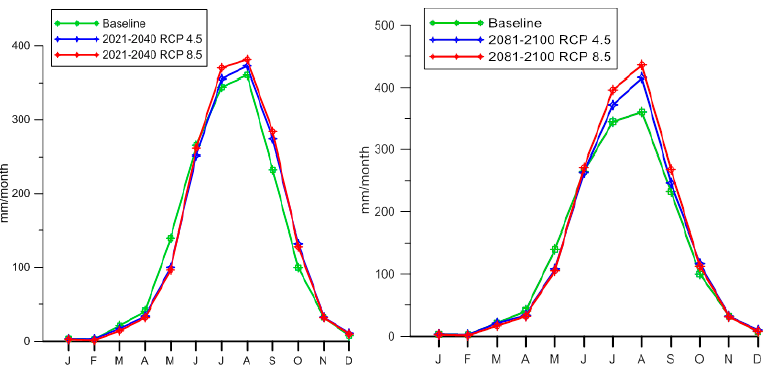
Figure 9. CCSM4 GCM projected monthly precipitation compared to the baseline.